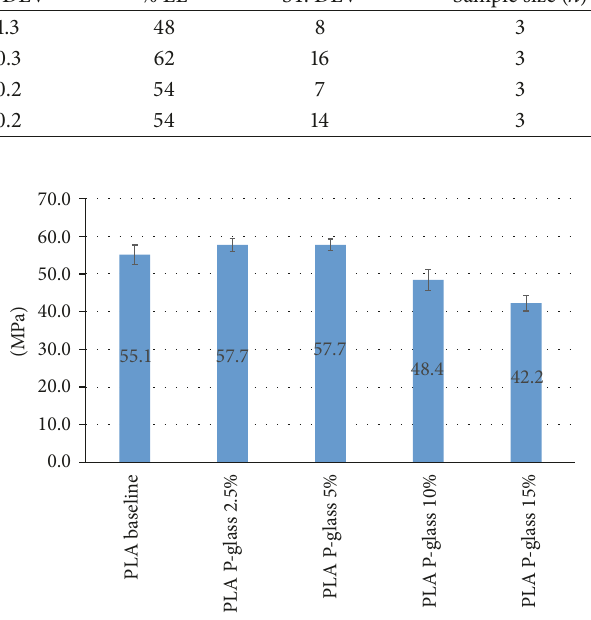
Figure 13: SEM micrographs of ABS:SEBS-g-MA loaded with P-glass at 20% by weight, (a) fracture surface and (b) filament (tangential view). Table 4: Tensile test results for ABS:SEBS-g-MA loaded with P-glass at 10% by weight printed at different temperatures. Material